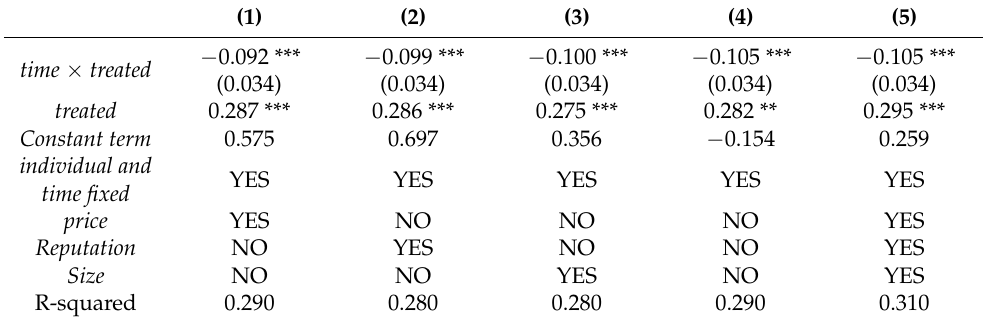
Table 5. The results of baseline